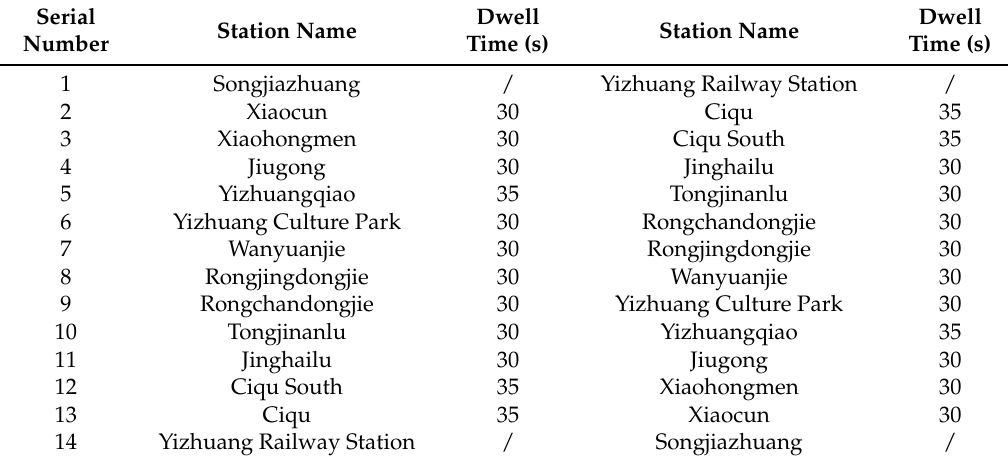
Table 3. Dwell times of Yizhuang subway line.